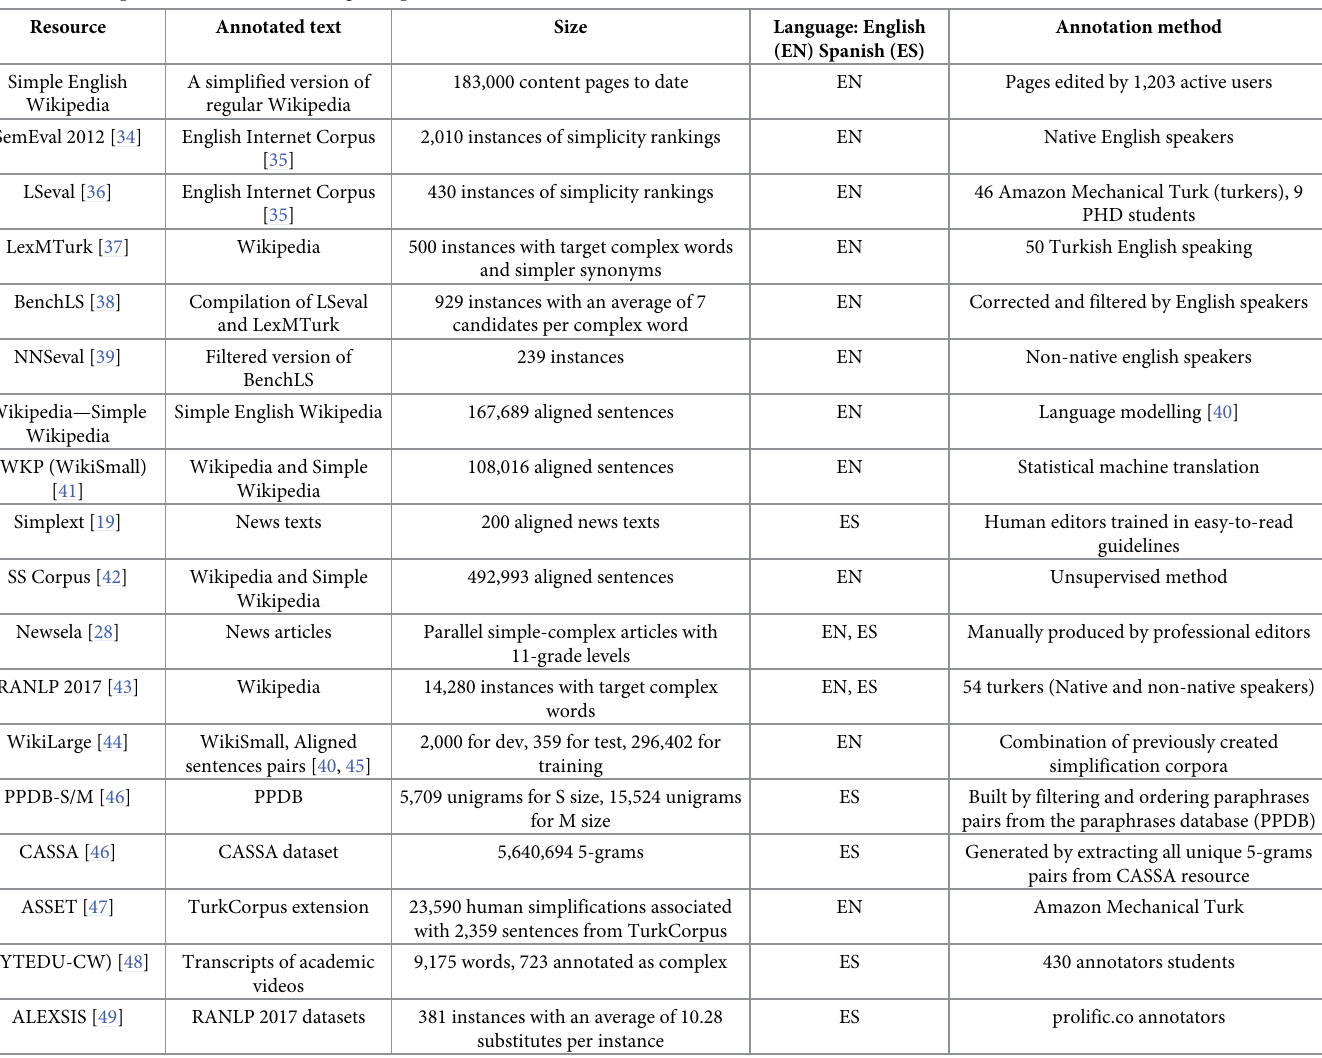
Table 1. Text simplification resources for